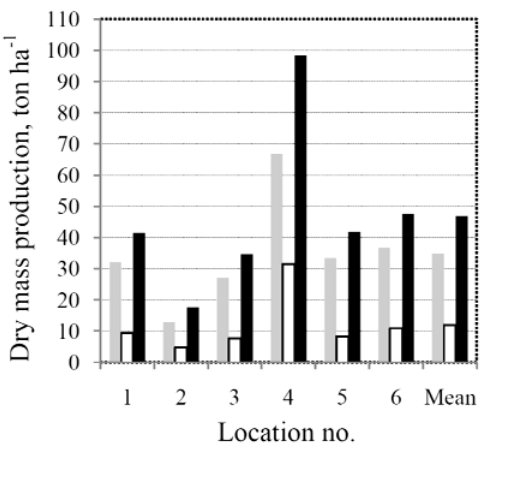
Figure 4. Total dry mass production (ton ha − 1 ) for stumps, roots and stump + roots from six poplar stands on former